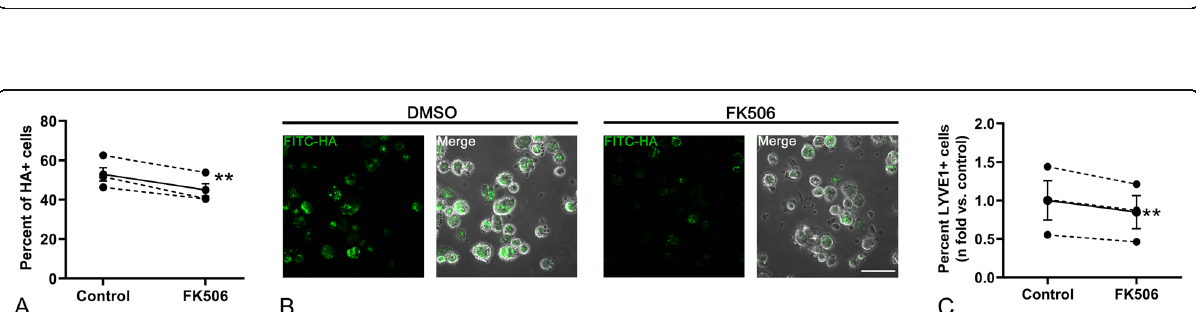
Fig. 5 FK506 inhibits TNF- α -induced lymphangiogenesis. Lung lymphatic endothelial cells were grown in 6 well dishes and treated or not with FK506 for 48 h (15 ng/ml). Cells were then placed on Matrigel and treated as indicated with or without TNF- α (100 ng/ml) or FK506 (15 ng/ml) for 16 h. After Calcein-AM labeling, random 4X images were taken and representative images of lymphangiogenesis in different treatment groups after Calcein-AM labeling are presented ( a ) (Size bar 200 μ m). Mesh area ( b ) and total segment length ( c ) were analyzed with ImageJ Angiogenesis Analyzer plugin. Results are expressed as mean ± SEM of one experiment. *** P < 0.001 by one-way ANOVA. Experiment was repeated once